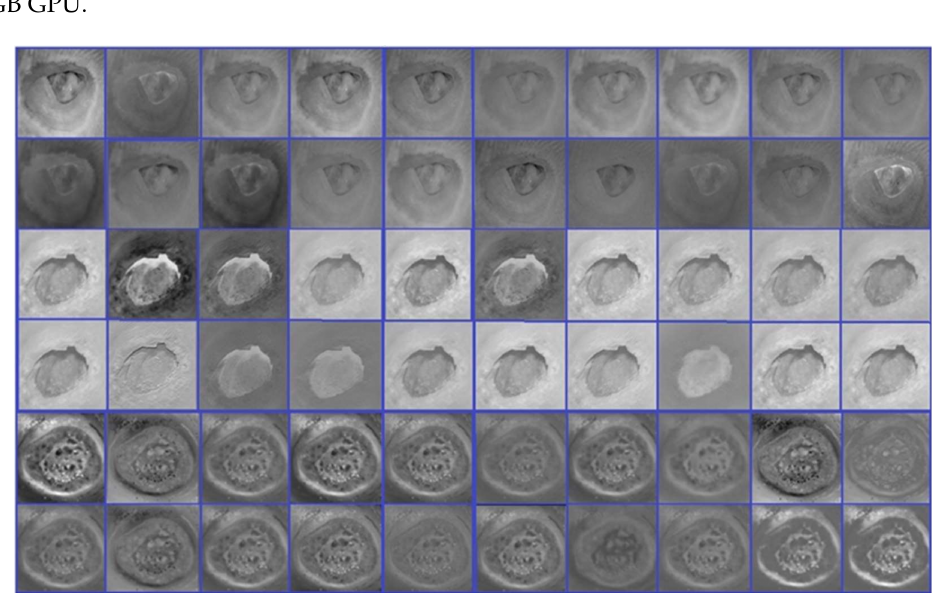
Figure 9. Learned filters of the abnormal class (DFU).